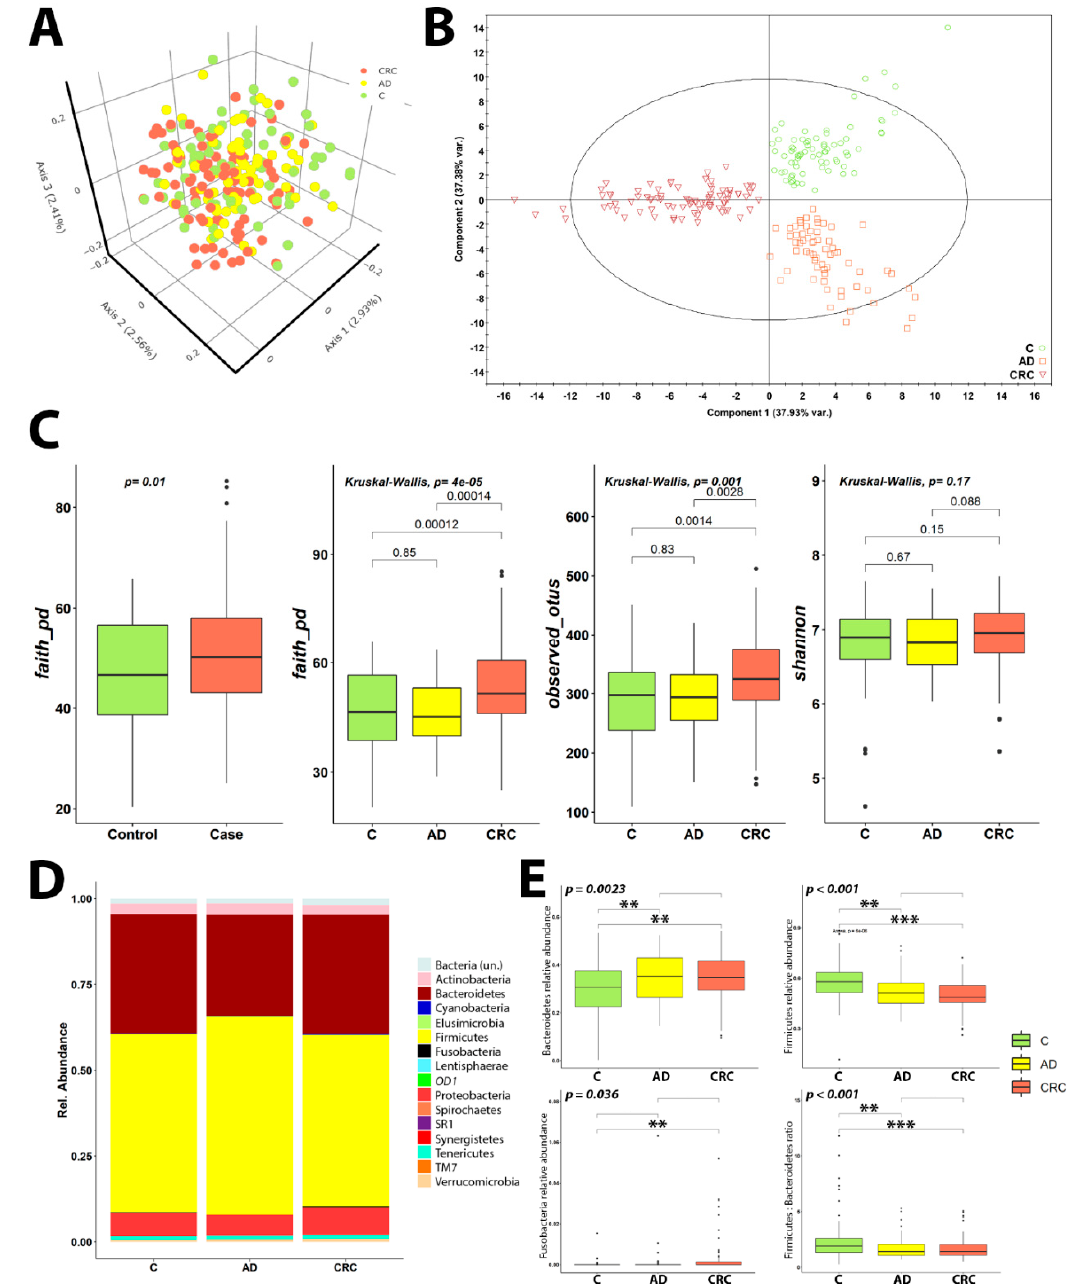
Figure 3. Diversity and taxonomical measurements of the microbiome data. Scores plot for the PCoA analysis performed upon Bray-Curtis distances of the microbiome. Points are colored depending on the sample clinical status ( A ). PLS-DA analysis of the Bray-Curtis distances. Point shapes and colors depend on the clinical status of samples ( B ). Alpha-diversity measurements of the distinct sample groups, Faith’s Phylogenetic Distance for both Case-Control and C-AD-CRC comparisons, Observed OTUs and Shannon diversity index for C-AD-CRC comparison ( C ). Mean relative abundances for all identified phyla per sample group stacked barplot, with di ff erent phyla colored di ff erentially ( D ). Distribution of phyla relative abundances on the most di ff erential ones, Bacteroidetes, Firmicutes and Fusobacteria per sample group. Di ff erences in the ratio of Firmicutes to Bacteroidetes relative abundances per sample groups. p -Value scores are indicated in the following manner: < 0.05, * < 0.01, *** < 0.001 ( E